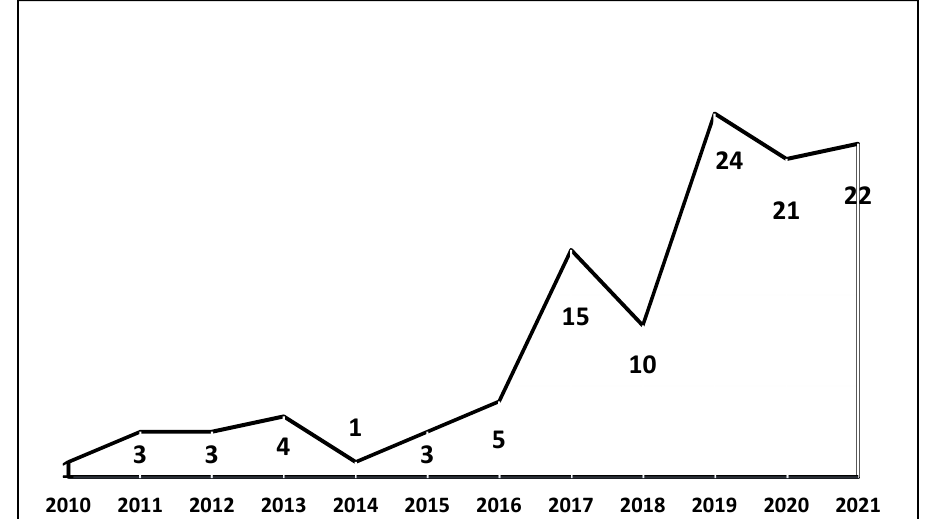
Figure 2. Dataset Distribution.